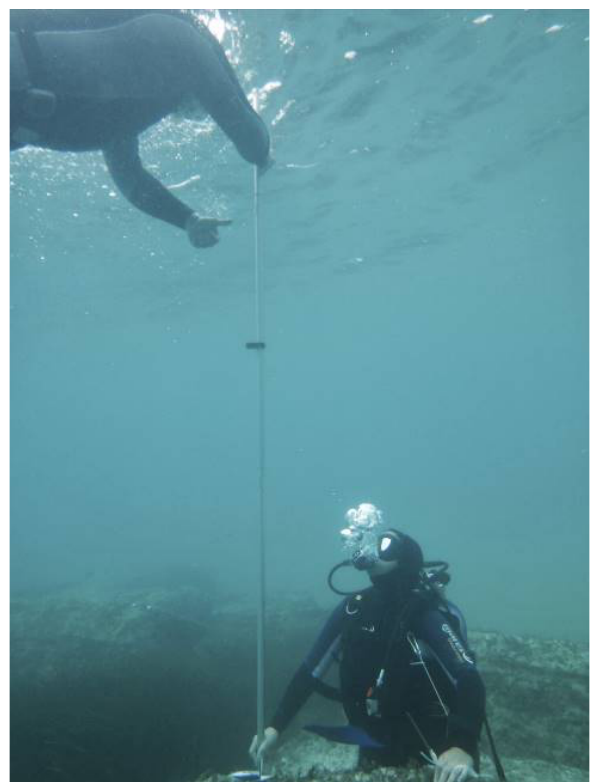
Figure 8. Cape Granitola shipwreck. Topographic measure of GCP. (photo: D. Della